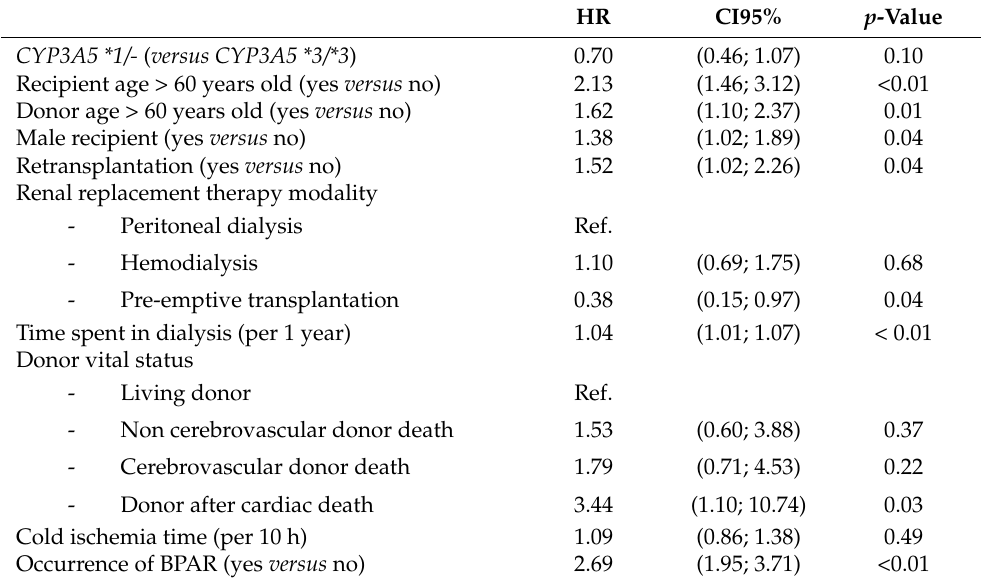
Figure 3. Longitudinal changes in tacrolimus daily dose/body weight ( A ), C0 ( B ) and C0/tacrolimus daily dose ratio ( C ) from 1 year post transplantation according to CYP3A5 genotype. As explained earlier, after 1 year post transplantation, the tacrolimus daily dose/body weight never exceeded 0.10 mg/kg/day regardless of CYP3A5 genotype (black dotted lines). Table 2. Multivariate Cox model for patient-graft